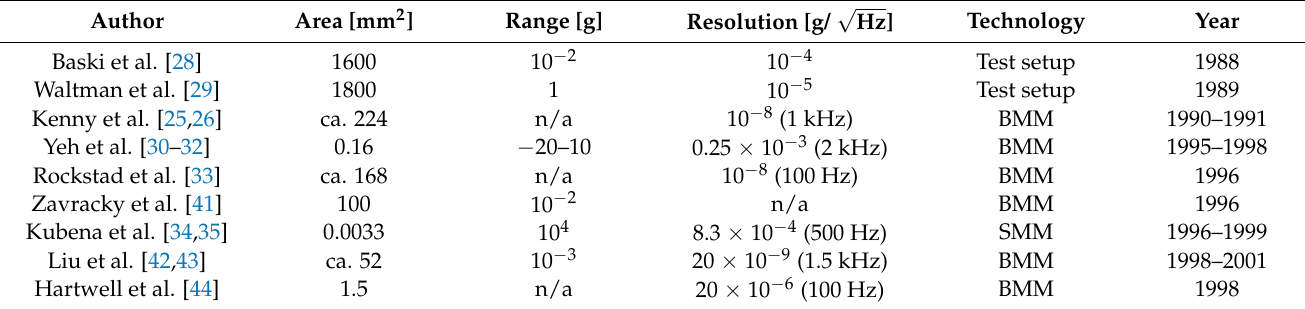
Table 1. Comparison of parameters of already published works on tunneling